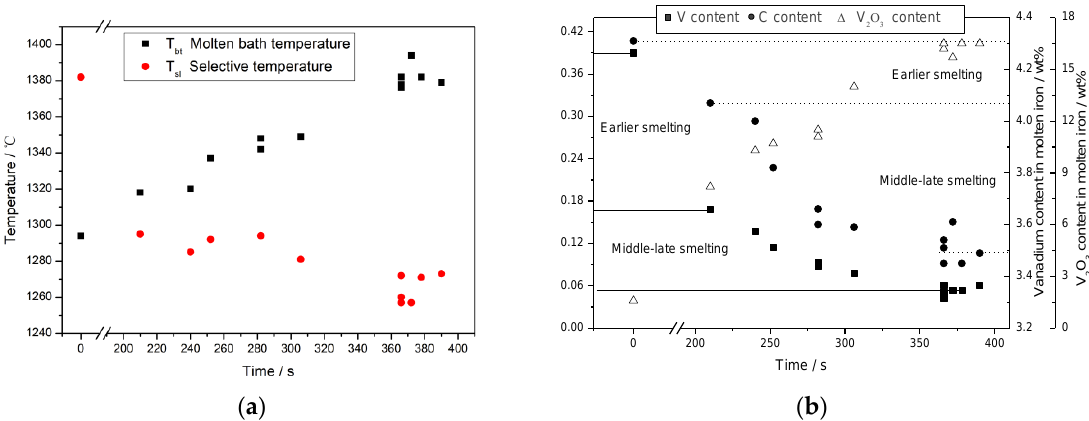
Figure 2. Variations on V, C, (V 2 O 3 ), the molten bath temperature and T sl . ( a ) variation on T bt and T sl , ( b ) variation on V, C, and (V 2 O 3 ).